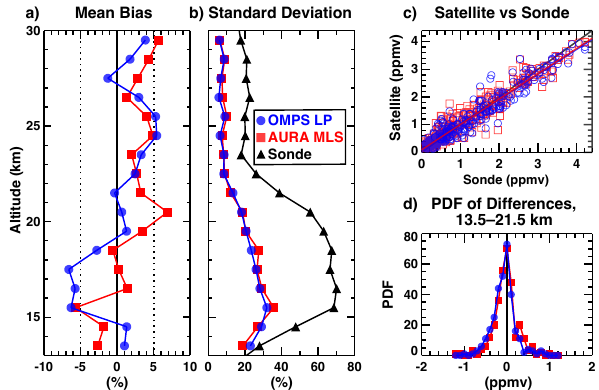
(%) Fig. 2. Comparison of OMPS LP and Aura MLS against the ozonesonde balloon measurements from Neumayer (70 ◦ S, 8 ◦ W) for September–November 2012. (a) Vertical profiles of mean dif- ferences and (b) standard deviations for OMPS LP (blue line and circles) and Aura MLS (red line and squares) relative to the sonde measurements. (b) also includes standard deviations of the sonde measurements relative to their time mean (black line and triangles). (c) OMPS LP and Aura MLS versus the sonde measurements in layers between 13.5 and 21.5km. (d) Probability density functions of the differences for OMPS LP and Aura MLS relative to the sonde measurements in layers between 13.5 and